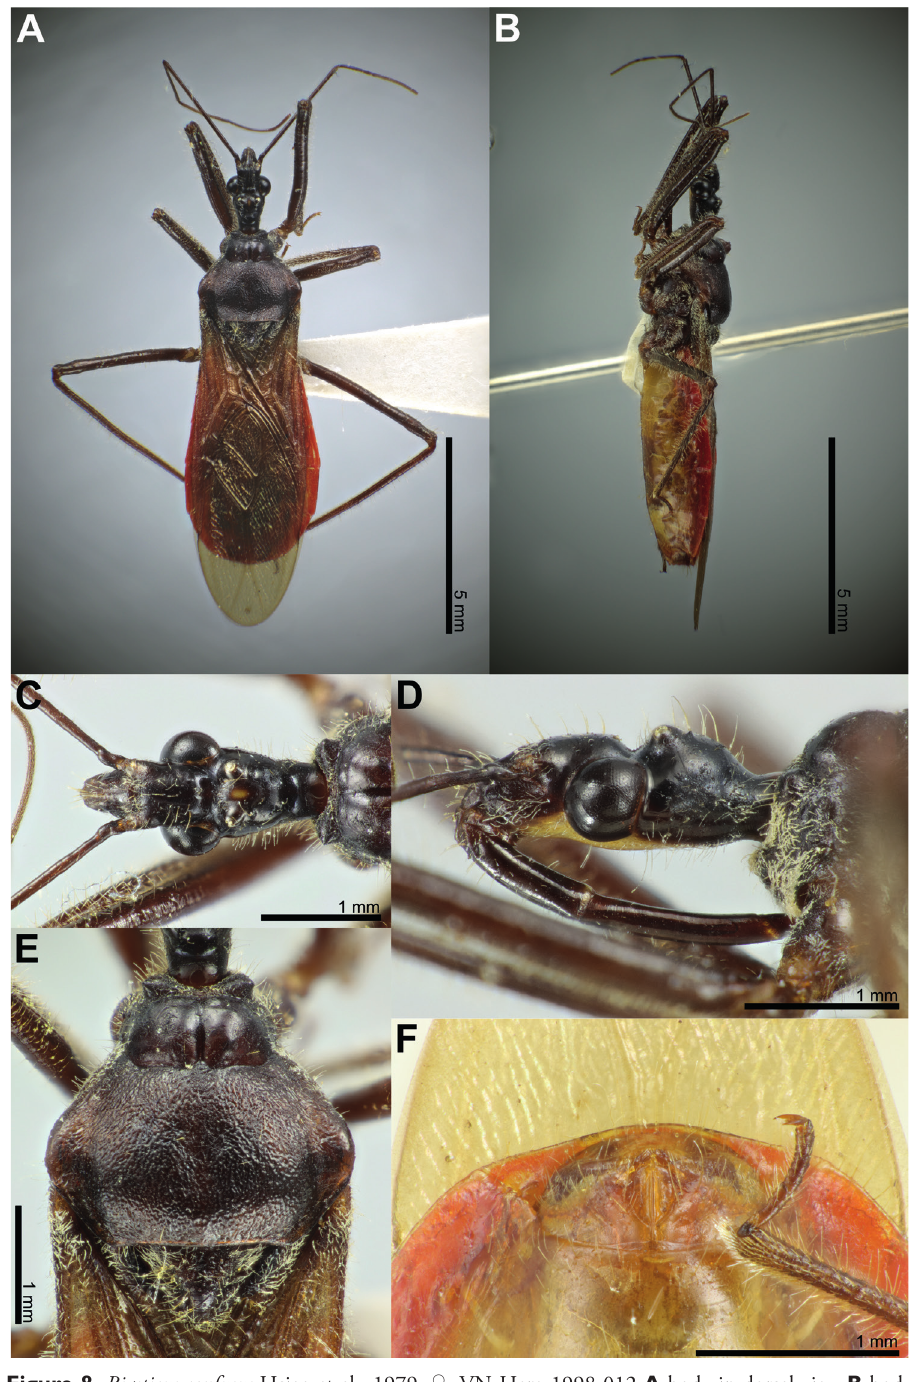
Figure 8. Biasticus confusus Hsiao et al., 1979, ♀ , VN-Hem-1998-012 A body in dorsal view B body in lateral view C head in dorsal view D head in lateral view E pronotum in dorsal view F female external genitalia in ventral